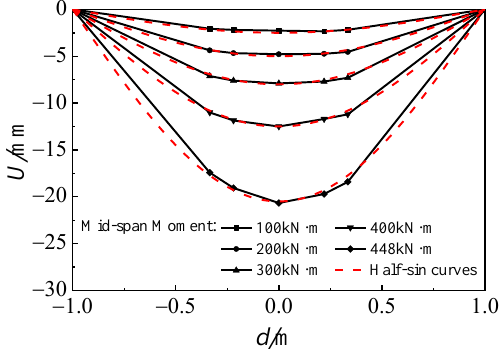
Figure 9. Typical deflection curves of the specimen S-2.